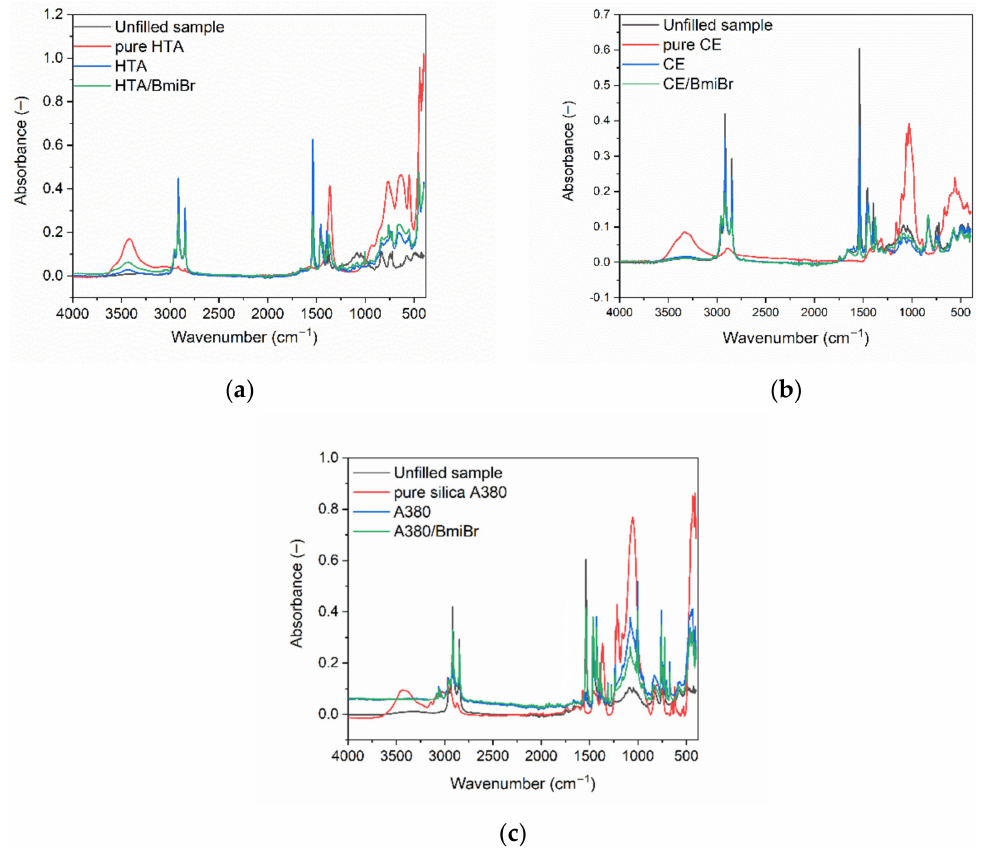
Figure 12. FT-IR spectra for NR vulcanizates filled with: ( a ) HTA; ( b ) CE; ( c )